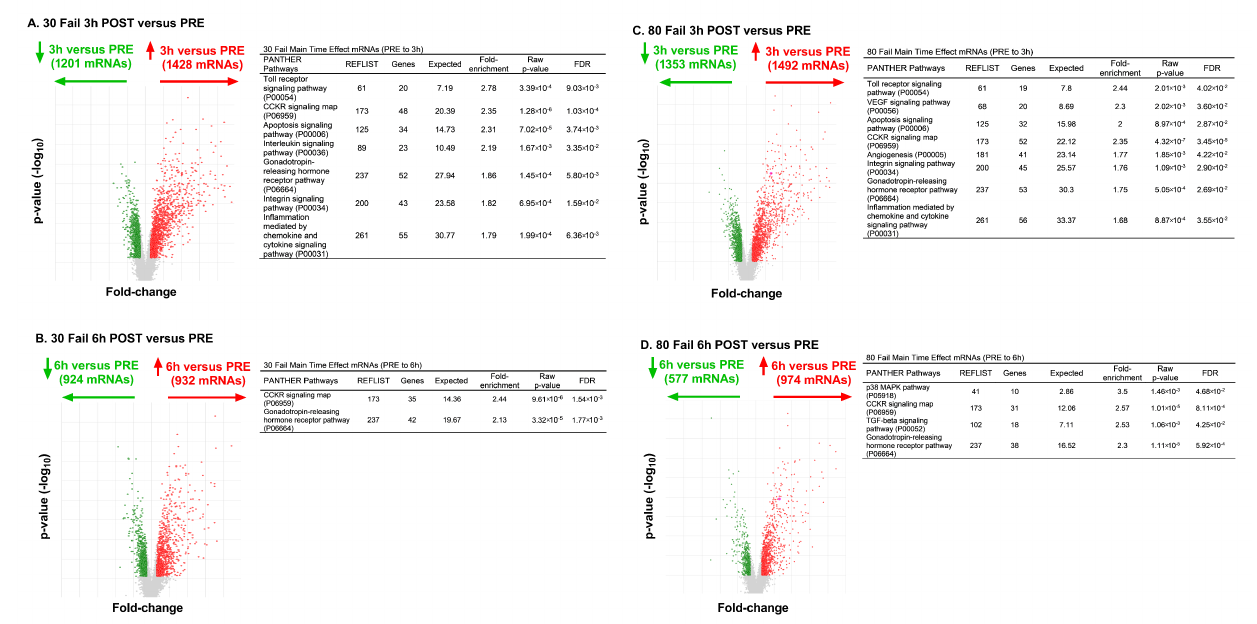
Figure 5. Time effect mRNAs between bouts with pathway enrichment data. Differentially expressed genes (DEGs) within the 30 Fail and 80 Fail bouts viewed as volcano plots and PANTHER pathway enrichment. More specifically, 30 Fail training DEGs from PRE to 3 h POST (panel A ), 30 Fail training DEGs from PRE to 6 h POST (panel B ), DEGs from PRE to 3 h POST with 80 Fail training (panel C ), and DEGs from PRE to 3 h POST with 80 Fail training (panel D ). Data are for n = 11 participants, all DEGs have a fold-change from PRE of ± 1.5 ( p < 0.01), and pathway analysis was significant if False Discovery Rate (FDR) p < 0.05. Abbreviations: 30 Fail, 30% one repetition maximum to failure bout; 80 Fail, 80% one repetition maximum to failure bout; REFLIST, reference gene list across human